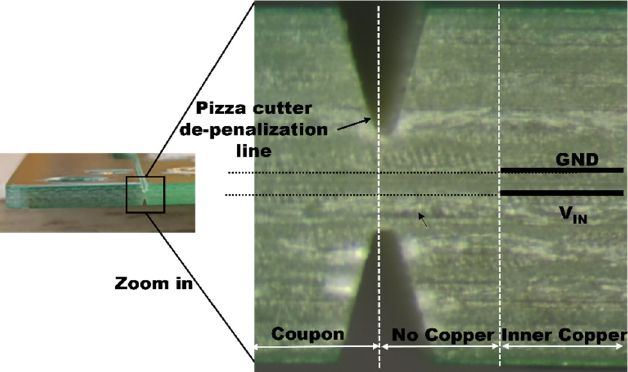
Figure 2. Cross-section of the board near the V-cut scoring area.